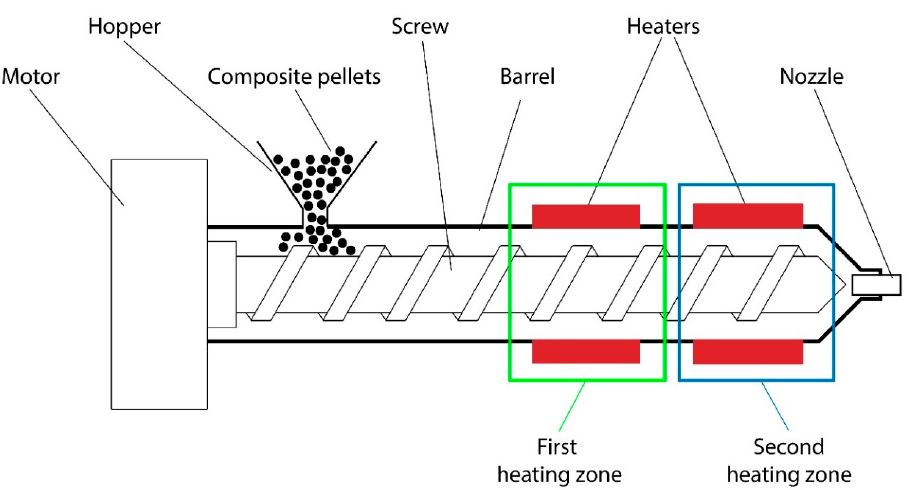
Figure 1. Schematic diagram of a purpose designed screw extruder used for the composite fiber preparation.